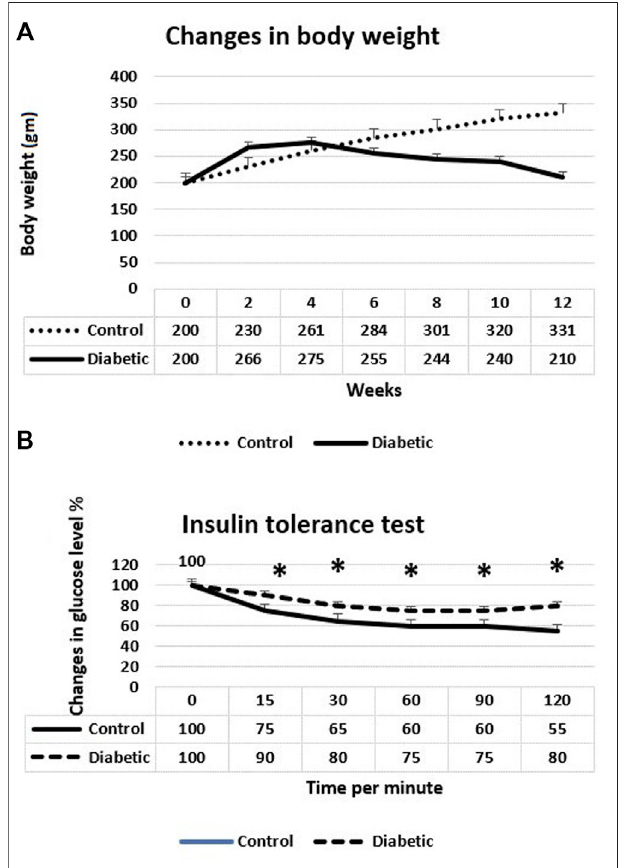
FIGURE 1 | (A) Changes in body weights of control and diabetic rats. The diabetic rats showed a signi fi cant decrease of their weight 8, 10, and 12 weeks after the induction of diabetes. (B) Insulin tolerance test at the 8th week after the induction of diabetes. The diabetic rats showed a signi fi cant weak response to insulin. * p <